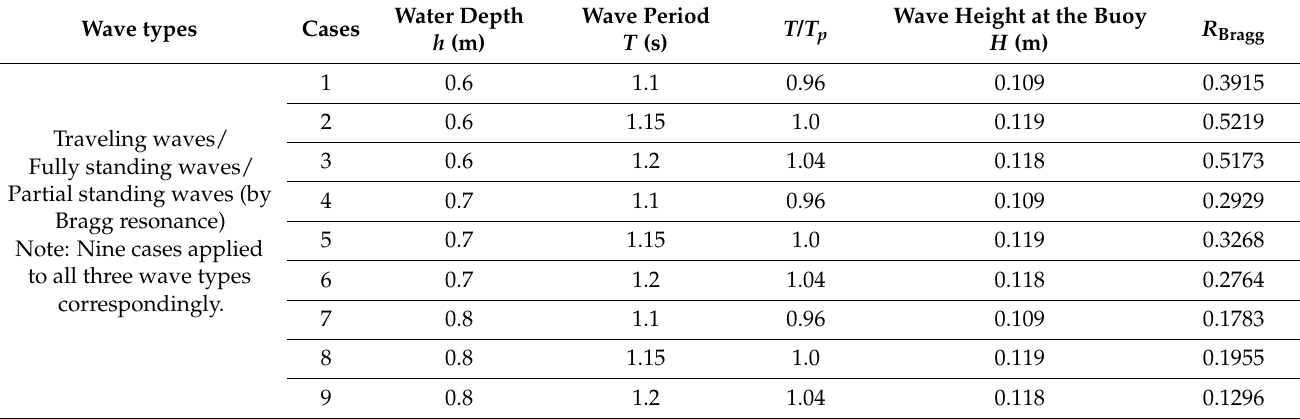
Table 1. The experiment group